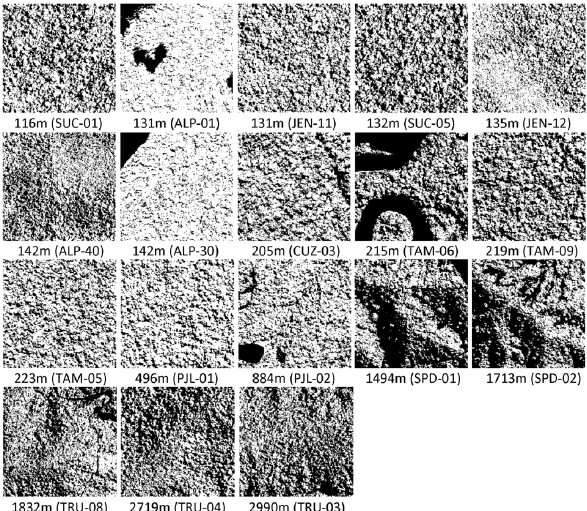
Fig. A1. Shade, ground and water mask (black areas) developed from airborne lidar and applied to all imaging spectrometer analyses (see Fig.